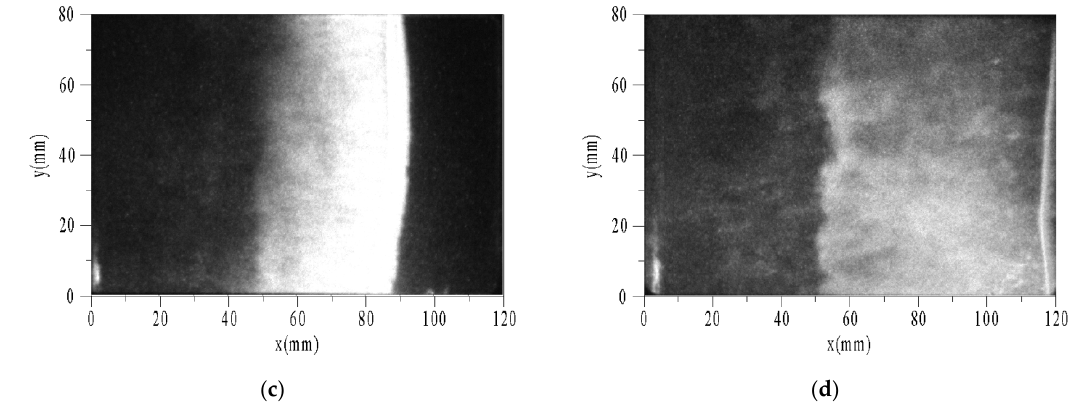
Figure 9. Sequential images of auto-ignition flow-field of toluene/O 2 /N 2 . ( a ) Δ t = 0; ( b ) Δ t = 25 μ s; ( c ) Δ t = 50 μ s; ( d ) Δ t = 75 μ s.